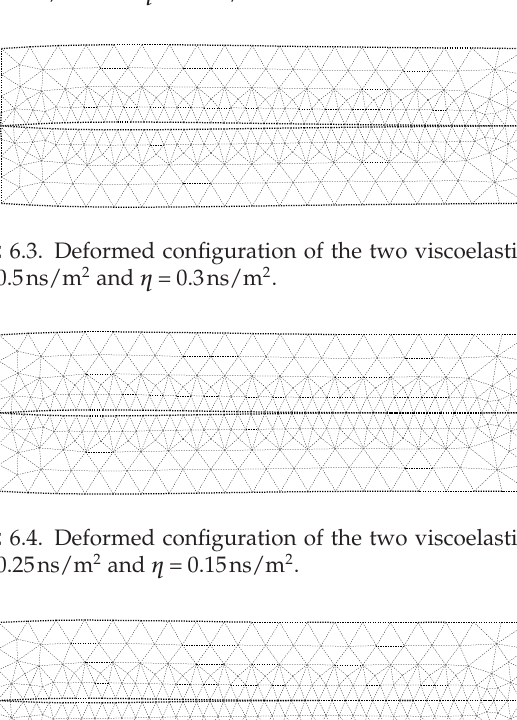
Figure 6.2 . Deformed configuration of the two viscoelastic bodies for µ = 1 . 0ns/m 2 and η = 0 . 6ns/m 2 .